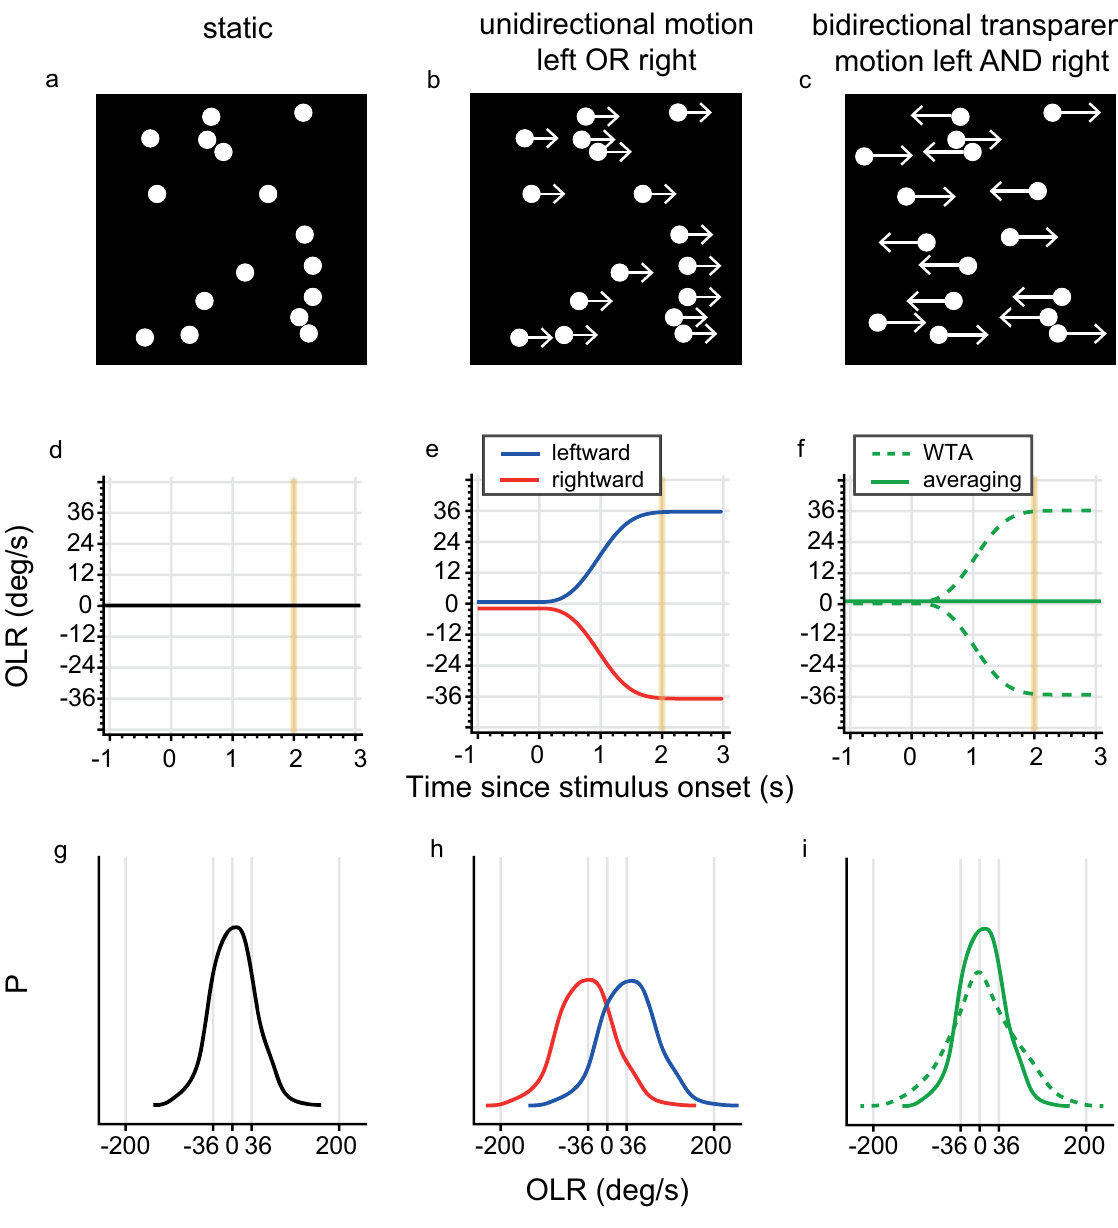
Figure 1. Stimuli and rationale. ( a – c ) Schematic drawings of the ( a ) static, ( b ) unidirectional right and ( c ) bidirectional visual motion stimuli. ( d – f ) Ideal schematic OLRs over time for the ( d ) static, ( e ) unidirectional and ( f ) bidirectional stimuli are shown, without response variability, biases or outliers. ( e ) Responses to left or right unidirectional motion are indicated by blue and red, respectively. ( f ) Note that the two models yield different responses: the averaging model, indicated by the solid green line, predicts an OLR of 0, while the WTA model, indicated by the dashed green line, predicts either a leftward or rightward turn. The vertical yellow lines indicate end of stimulus, 2 s after stimulus onset. ( g – i ) Schematic OLR probability distribution determined at 2 s after stimulus onset are shown for each stimulus, including response variability. The drawings for the ( g ) static and ( h ) unidirectional stimuli are fictional, but resemble data observed in earlier reports 18,19 . ( i ) The OLR probability distributions according to the WTA (dashed green line) and averaging (solid green line) readout rules are predicted from the fictional unidirectional motion response data in ( h ) (see Methods for exact predictions determined from unimodal response distributions). Note that both distributions are unimodally peaked, yet can be distinguished by their